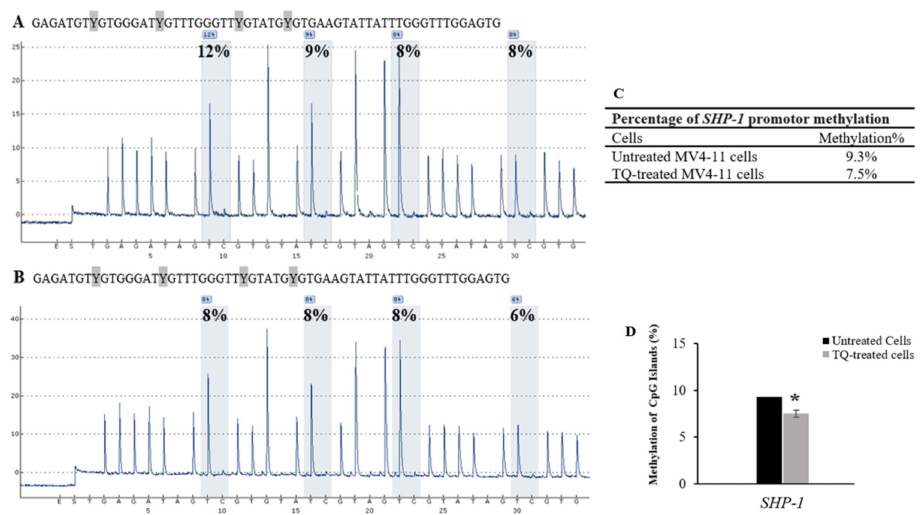
Figure 5. Effect of TQ on the methylation of SHP-1 promoter 2 region in MV4-11 cells. ( A ) Pyrose- quencing pyrograms for the SHP-1 promoter 2 region methylation status in untreated MV4-11 cells and ( B ) TQ-treated MV4-11 cells. The percentages shown above each “C” base are the methylation level of the CpG site. ( C ) Percentages of SHP-1 methylation in MV4-11 cells. ( D ) The bar graph shows hypomethylation of SHP-1 in MV4-11 cells after TQ treatment. Repeated measures ANOVA was applied and the values are stated as mean ± SD; where * p < 0.05 is significant versus untreated control cells.